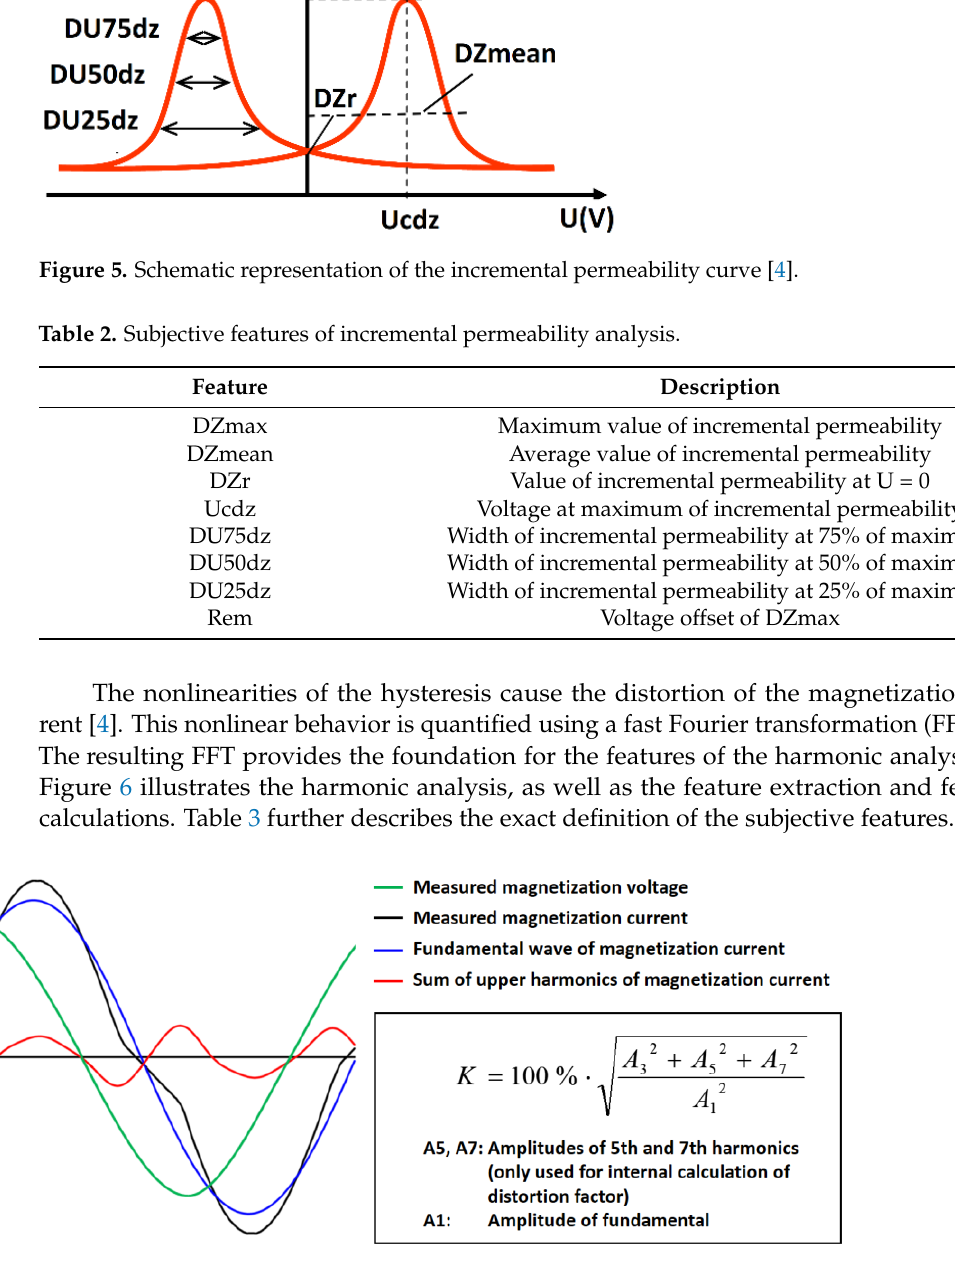
Figure 6. Schematic representation of the harmonic analysis [4]. Table 3. Subjective features of the harmonic